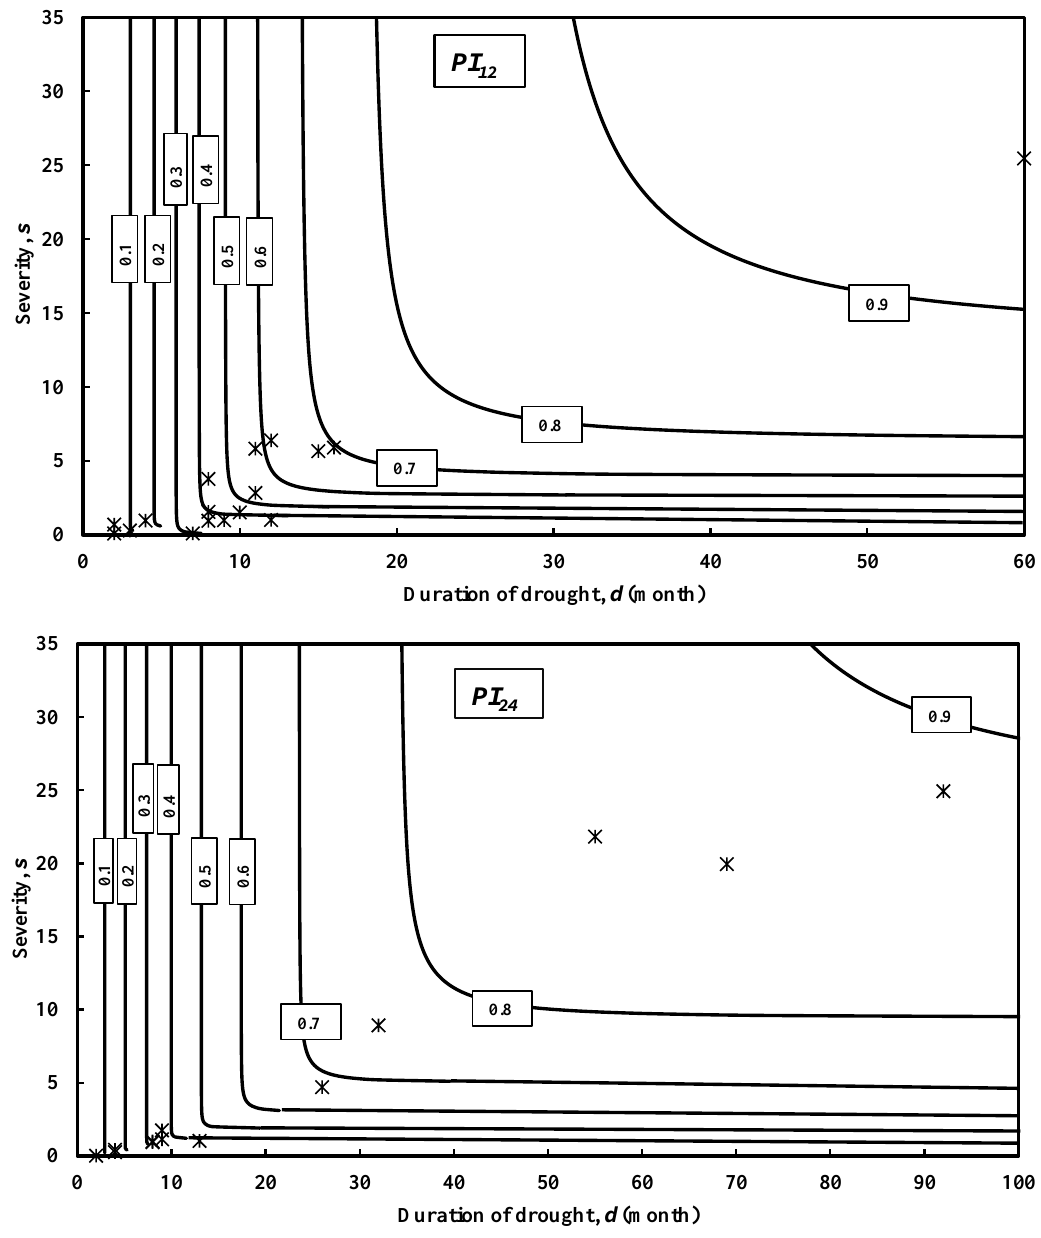
Figure 9. Contour plot for bivariate probability distribution for drought duration and severity. Scattered points denote observed drought event.